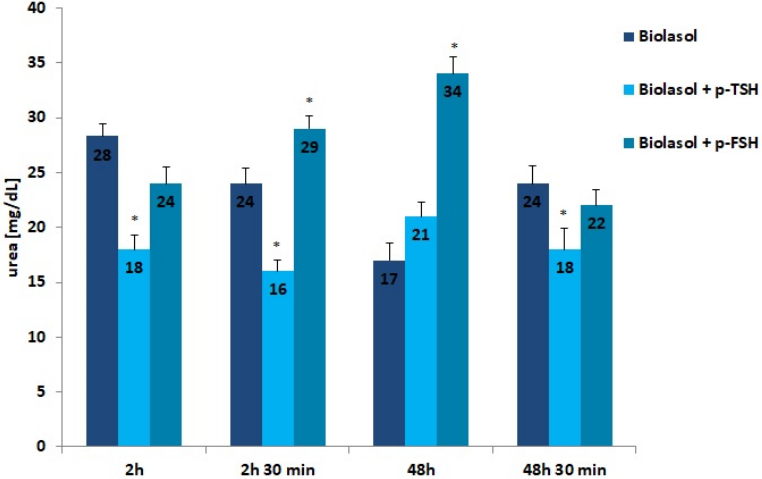
Figure 5. Creatinine concentrations in the collected perfusates. The values are expressed as mean ±